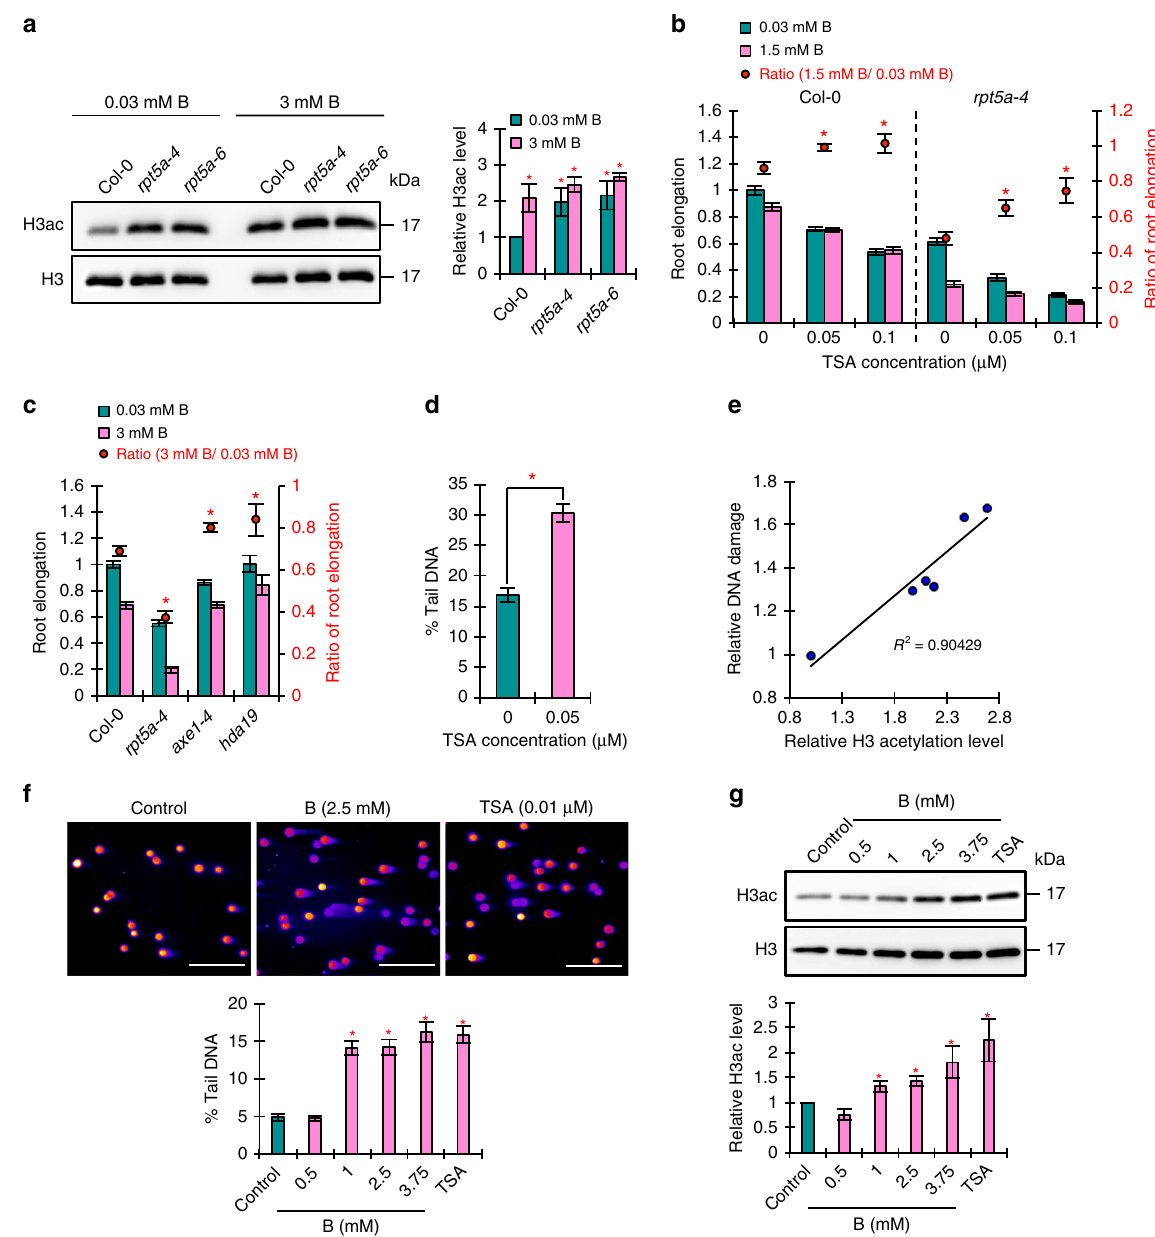
Fig. 9 Histone hyperacetylation is the main cause of DSB induction under high-B stress. a Levels of histone H3 acetylation in the roots of Col-0 and rpt5a mutant plants grown under normal- and high-B conditions. The right panel shows the relative level of acetylated histone H3 accumulation normalized against total histone H3 ( n = 3, average ± s.e.m.; * P < 0.05, compared with Col-0 under 0.03 mM B conditions, Student ’ s t -test). b Effect of histone hyperacetylation induced by TSA treatment on the sensitivity of Col-0 and rpt5a-4 to high-B stress. Values for root elongation are ratios relative to the value of Col-0 under 0 μ M TSA conditions. Red circles represent the ratio relative to the value under 0.03 mM B conditions without TSA ( n = 17 – 19, average ± s.e.m.; * P < 0.05, compared with 0 μ M TSA conditions, Student ’ s t -test). c Sensitivity of root growth of Col-0 and hdac mutants to high-B stress. Values for root elongation are ratios relative to the value of Col-0 under 0.03 mM B conditions. Red circles represent the ratio relative to the value under 0.03 mM B conditions ( n = 15 – 20, average ± s.e.m.; * P < 0.05, compared with Col-0, Student ’ s t -test). d Effect of histone hyperacetylation on levels of DSBs in Col-0 root tips ( n = 102 – 111, average ± s.e.m.; * P < 0.05, compared with 0 μ M TSA conditions, Student ’ s t -test). e Relationship between levels of histone H3 acetylation and DSB accumulation under high-B conditions according to data from Col-0, rpt5a mutants, brm-3 , and two BRM high-expression transgenic plants. f Representative images of comet assays with high-B- and TSA-treated HeLa cells. Scale bars, 50 µ m. The lower panel shows the levels of DSBs in HeLa cells treated with various levels of B and 0.01 μ M TSA ( n = 105, average ± s.e.m.; * P < 0.05, compared with control conditions, Student ’ s t - test). g Levels of histone H3 acetylation in HeLa cells treated with various levels of B and 0.01 μ M TSA. The lower panel shows the relative level of acetylated histone H3 accumulation normalized against total histone H3 TSA ( n = 4 – 5, average ± s.e.m.; * P < 0.05, compared with control